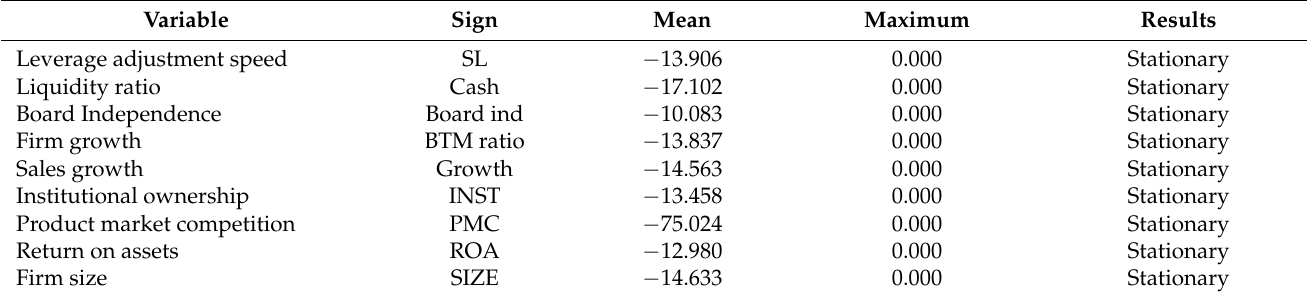
Table 4. Levin, Lin and Chu test-quantitative research variables.